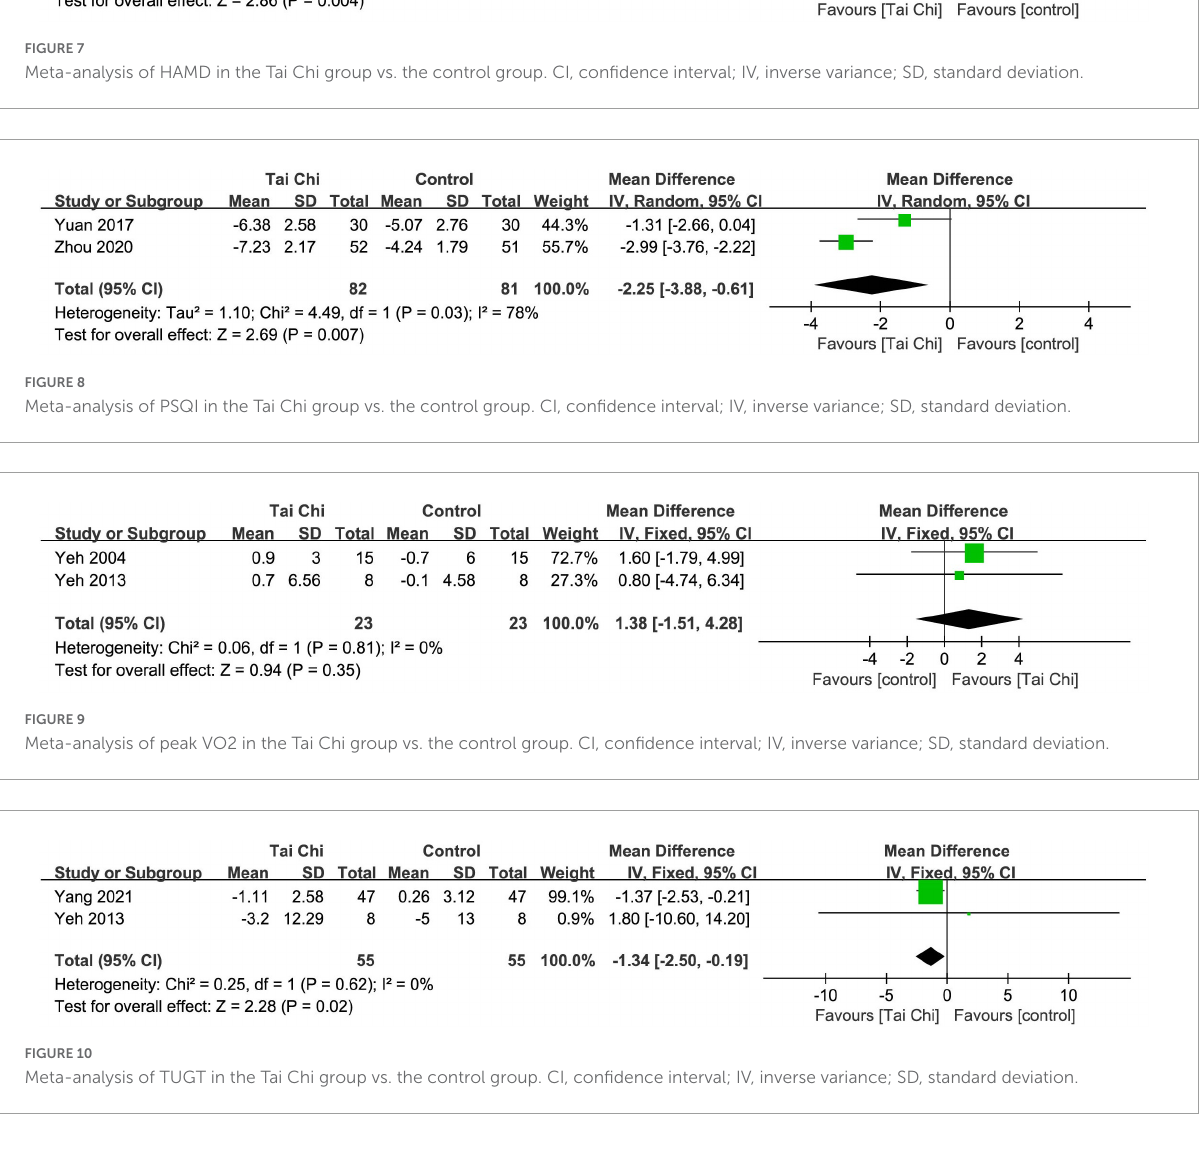
the fixed-effects model was used ( Figure 9 ). Sensitivity analysis was not conducted because of insufficient numbers of included